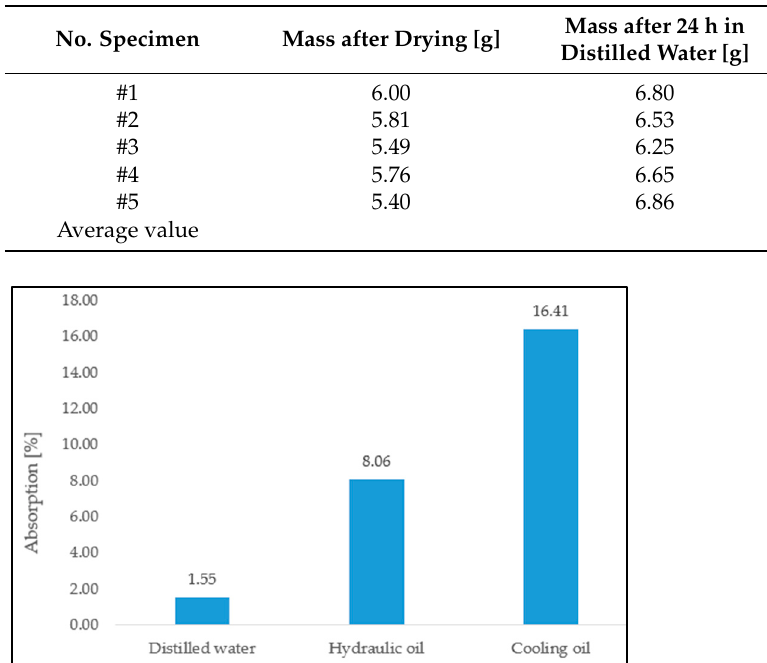
Figure 4. Average absorption level in Ecoflex 00-30 specimens in the three liquid environments.